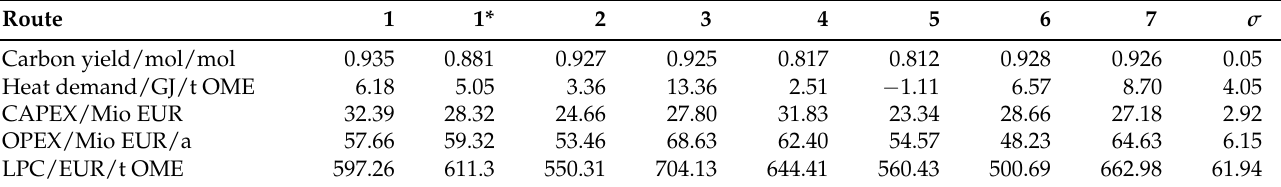
Table 4. Key results for all routes for a plant size of 100 kt OME production per year and a methanol price of 401 EUR/t. The standard deviation is given in the last column to indicate the size of the occurring differences in a KPI. However, one should keep in mind that the routes are based on different technologies when comparing them